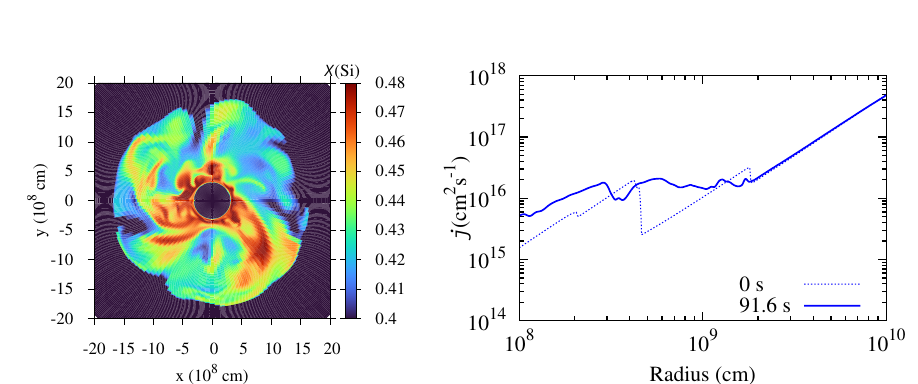
Figure 2. Left panel: Slices in the x - y plane showing the silicon mass fraction distribution at the last time step (91.6 s) of the fast-rotating 38 M ⊙ star. Right panel: Radial profiles of the angle-averaged specific angular momentum at the initial (dotted curve) and last (solid curve) time